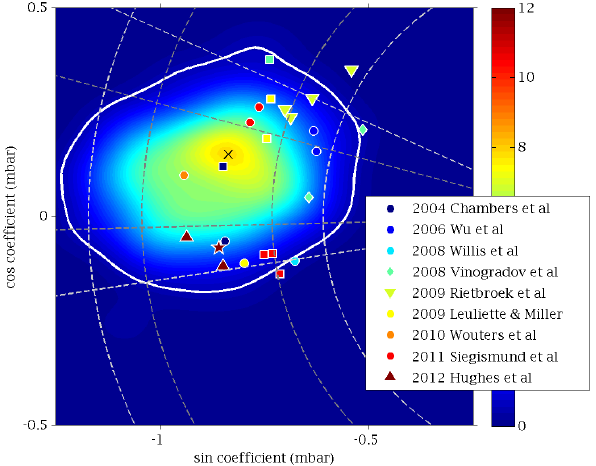
Figure 13. Probability distribution function of annual amplitude and phase for best sites (6, 10–15, 17) simultaneously with noise added to the bottom-pressure records, using both ECCO and NEMO12. 95% of results fall inside the white contour. The peak of the distribution is emphasised with a black cross, and grey dashed lines indicate one standard error and the 95% bounds for ampli- tude and phase independently. With predictions for the ocean mass annual from previous studies: colours indicate publication, basis of method is indicated by circles (GRACE), squares (altimetry-steric), diamonds (ECCO model), stars (hydrology), up-triangles (bottom pressure), down-triangles (GRACE with complementary constraints including bottom-pressure data). Note that axes are zoomed from earlier figures, PDF colours are the